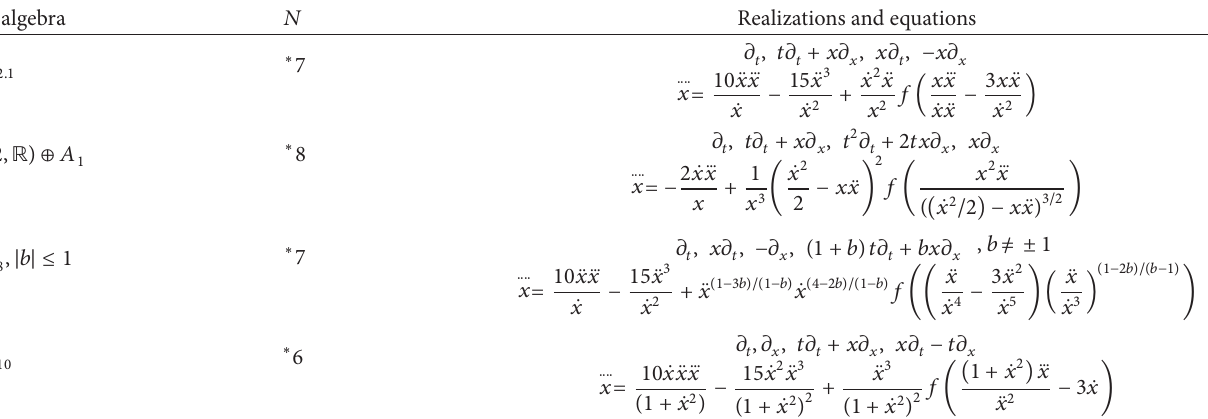
Lie algebra 𝑁 Realizations and